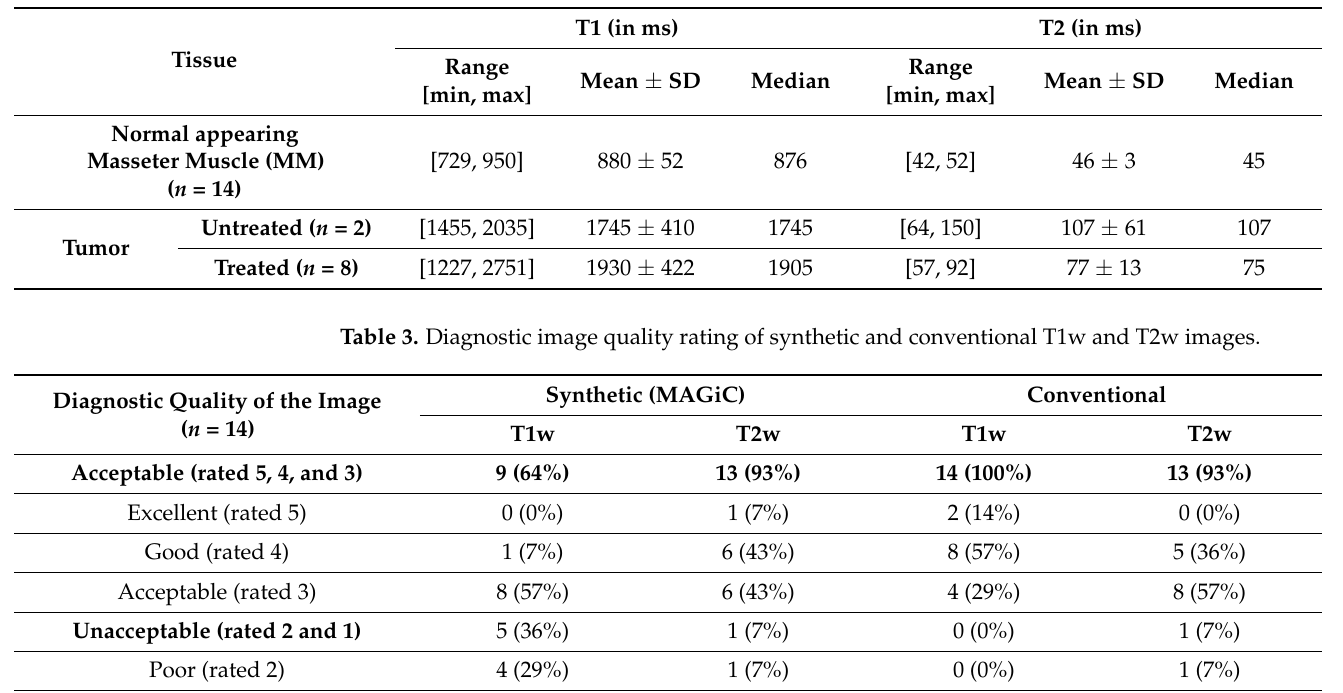
Table 2. T1 and T2 values from normal-appearing masseter muscle and tumor regions.